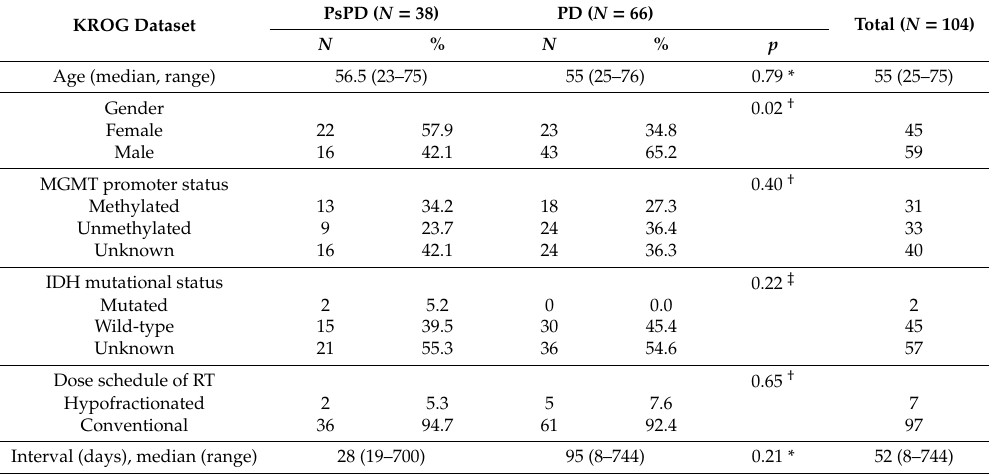
Table 1. Patient characteristics for the KROG